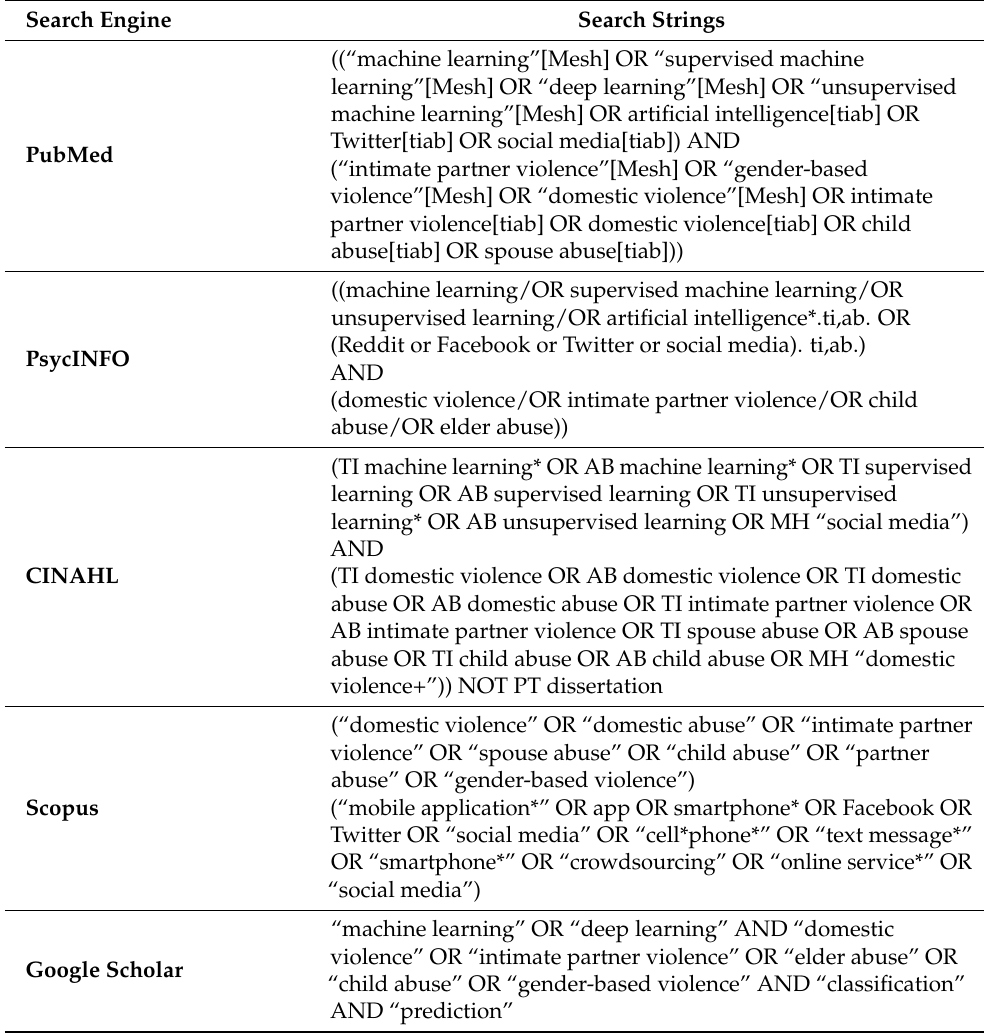
Table 1. Search strings for different search